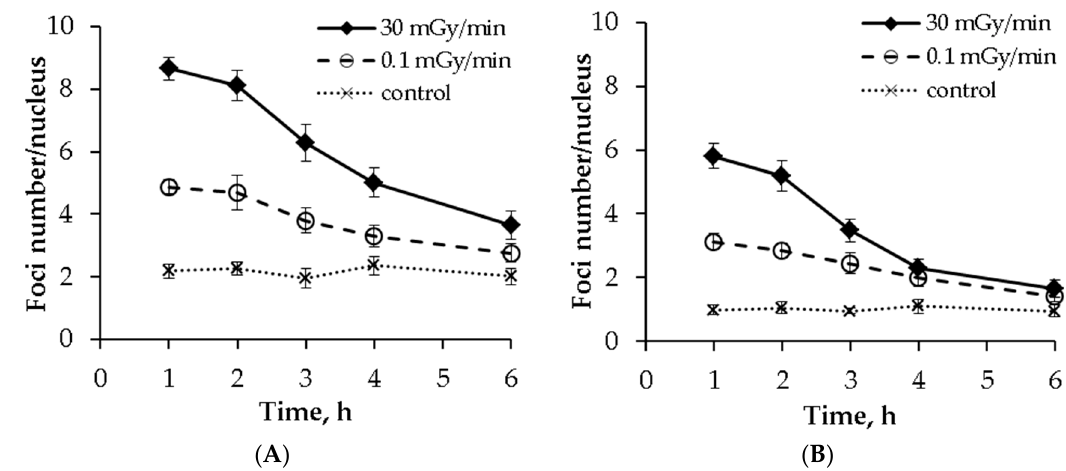
Figure 4. Post-irradiation kinetics of ( A ) γ H2AX and ( B ) pATM foci in MSCs exposed either acutely or chronically to γ -radiation. The mean and SEM of three independent experiments are shown.